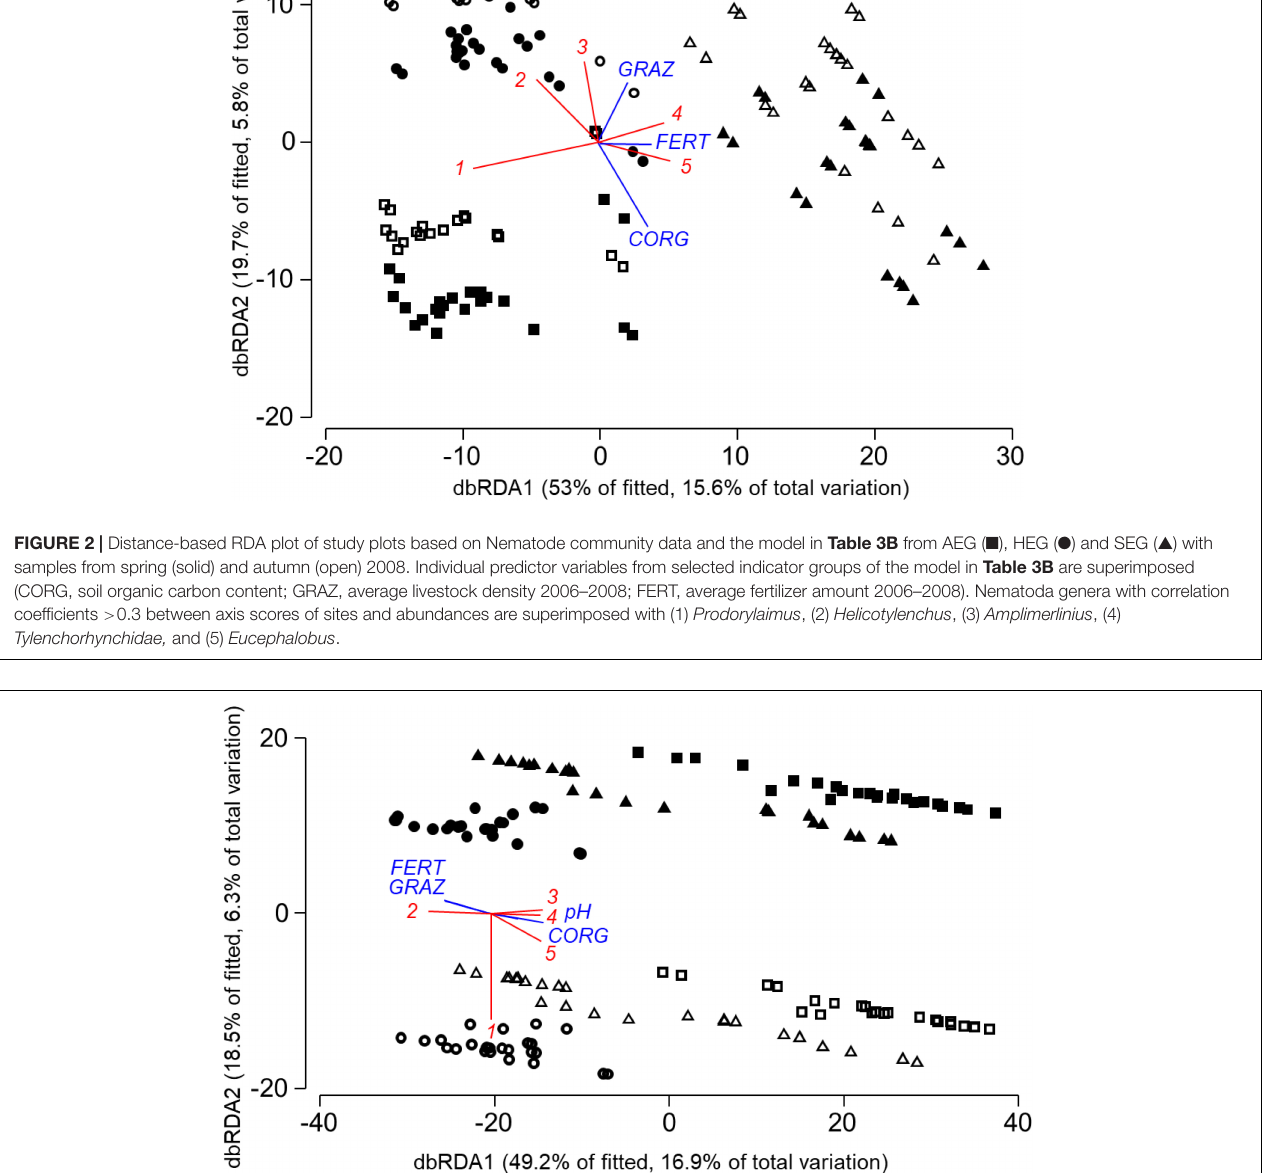
not only promoted microbial growth, but also shifted the soil fungal to bacteria ratio toward bacteria (see also De Vries et al., 2006). Interestingly, as previously indicated also